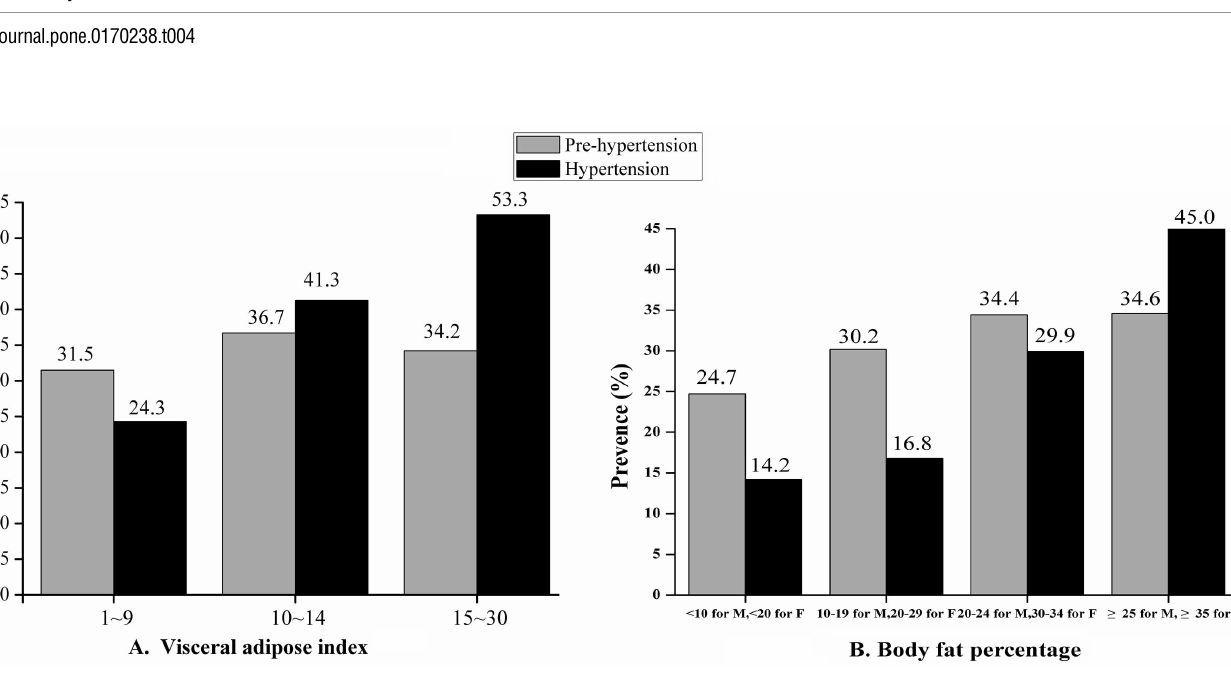
Fig 2. Prevalence of prehypertension and hypertension stratified by VAI and BFP. (A) Prevalence of prehypertension and hypertension stratified by visceral adiposeindex; (B) Prevalence of prehypertension and hypertension stratified by body fat percentage.